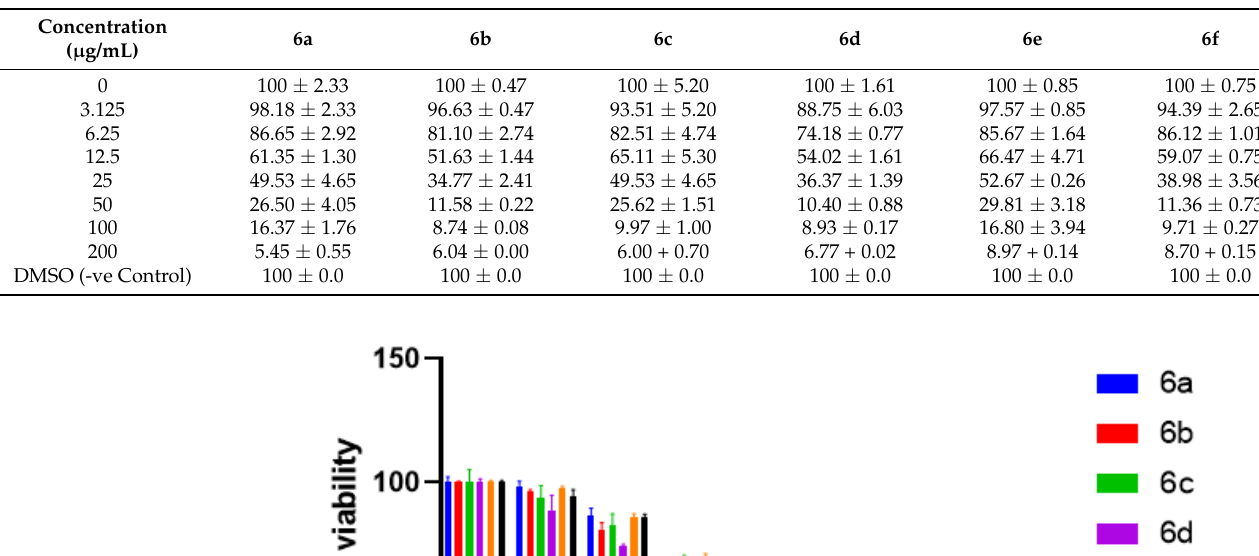
Table 2. Cell viability of derivatives 6a–6f at different concentrations (µg/mL).